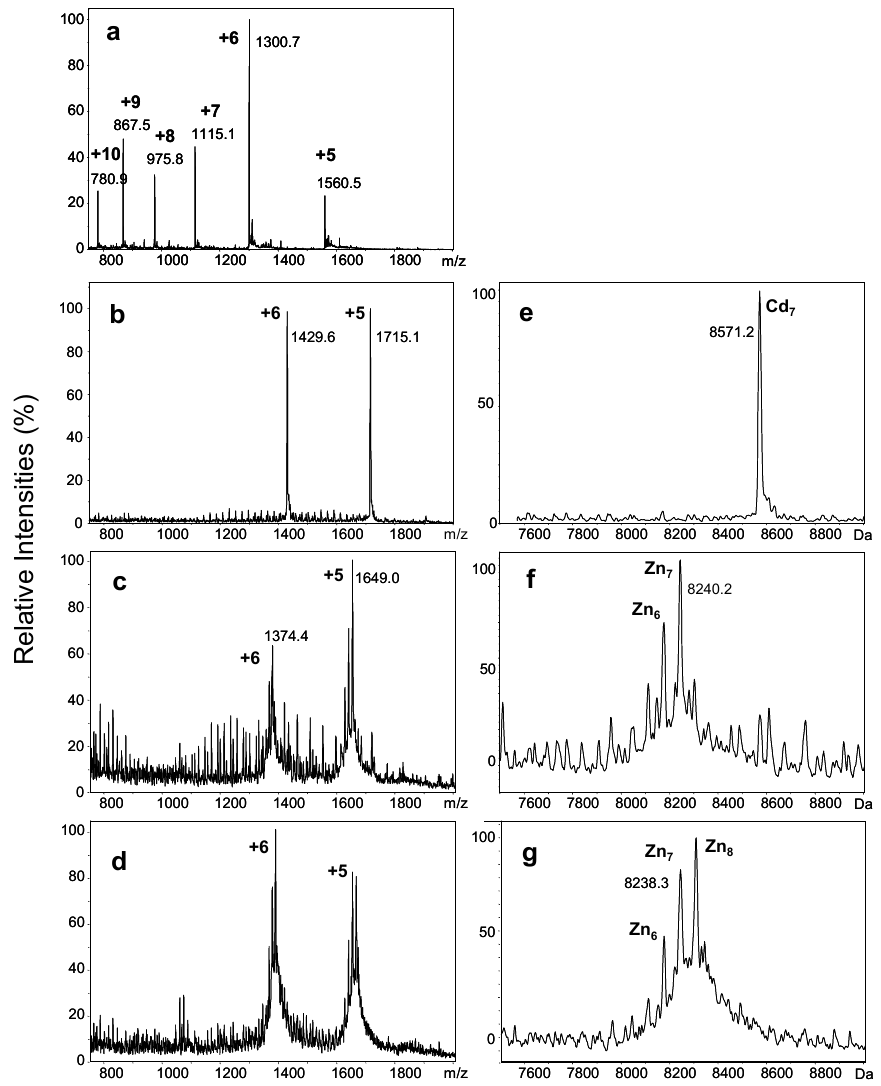
Figure 2. Raw ( a – d ) and deconvoluted ( e – g ) mass spectra of recombinant wMT-2 (10 mM NH 4 HCO 3 , 10% MeOH) ( a ) Raw mass spectrum showing charge states for demetallated wMT-2 at pH < 2.0. Deconvolution onto a true mass scale gives a neutral mass of 7798.4 Da; ( b , e ) MS data for wMT-2 expressed and purified in the presence of Cd(II); ( c – g ) MS data from two different expressions in the presence of Zn(II). Spectra ( b – f ) were recorded at pH 8.5, spectra ( d , g ) at pH 7.0. The low signal to noise ratio in spectra ( c – g ) is due to the low concentration of the protein, which in turn was due to rapid sample degradation. The series of additional peaks between m / z 1000 and 1700 seen in ( b , c ) correspond to polyethylene glycol, contamination with which can occur through use of ultracentrifugation filters.